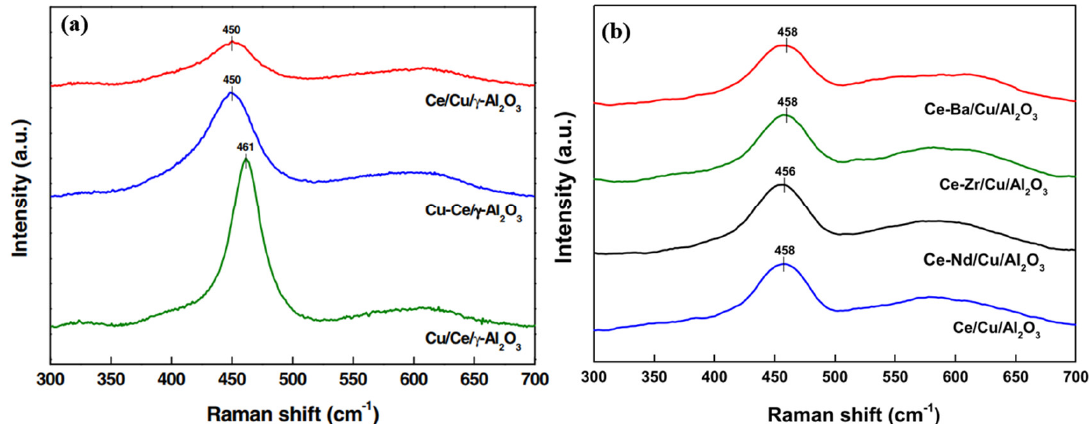
Figure 5. Raman spectra of the Cu-based catalysts: ( a ) Cu/ γ –Al 2 O 3 catalyst and CeO 2 –promoted Cu/ γ –Al 2 O 3 catalysts. Adapted from Ref. [27]. Copyright 2016 Elsevier. ( b ) Ce/Cu/Al 2 O 3 catalysts with various additives. Adapted from Ref. [48]. Copyright 2020 Elsevier.